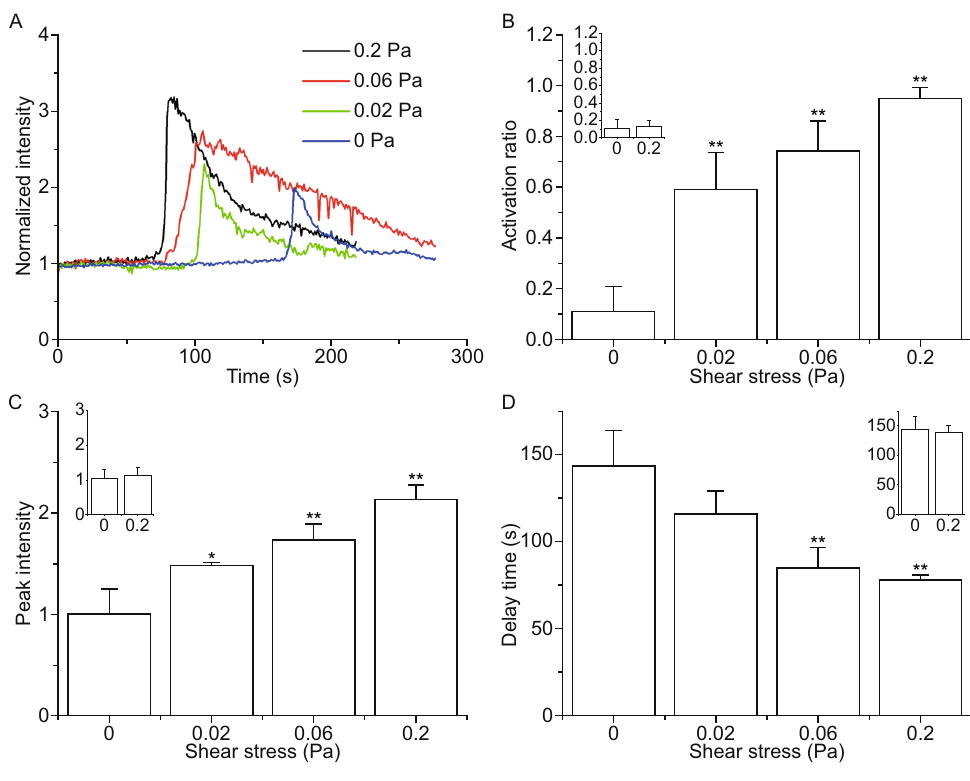
Figure 4. Variation of activation ratio, peak intensity, and delay time for calcium signaling of fi rmly adhered neutrophils against shear stress. The plots illustrate the time-course (A), activation ratio (B), peak intensity (C) and delay time (D) for calcium signaling of fi rmly adhered neutrophils on substrate coated with 10 μ g/mL P-selectin under wall shear stresses of 0.0, 0.02, 0.06 and 0.2 Pa. The data represent the mean ± SEM from at least 20 cells in 3 experiments. Each inset in B, C or D presents the calcium signaling of neutrophils on blank substrate under wall shear stresses of zero and 0.2 Pa. The signi fi cant level of difference from static group was shown by P -value, * for P < 0.05 and ** for P